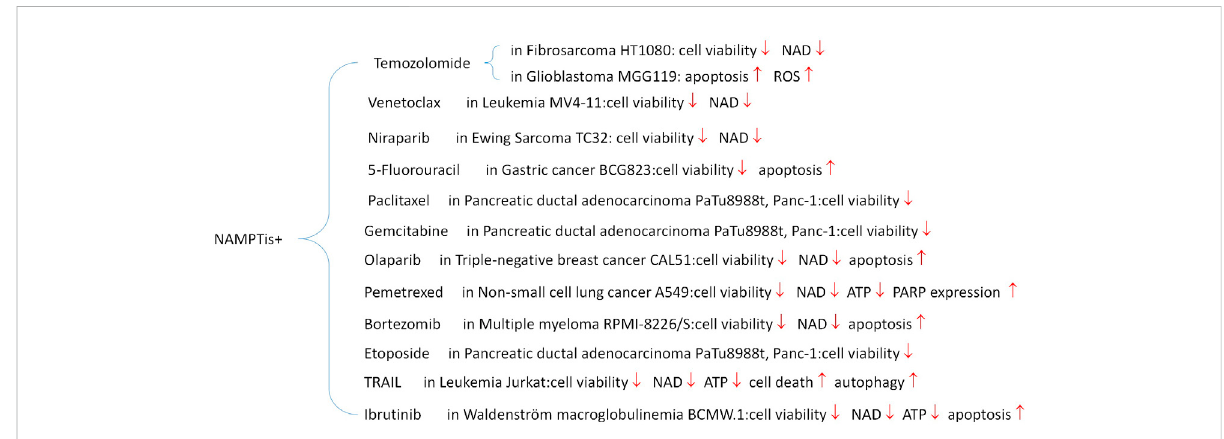
FIGURE 8 Performance of drug combination in vitro .